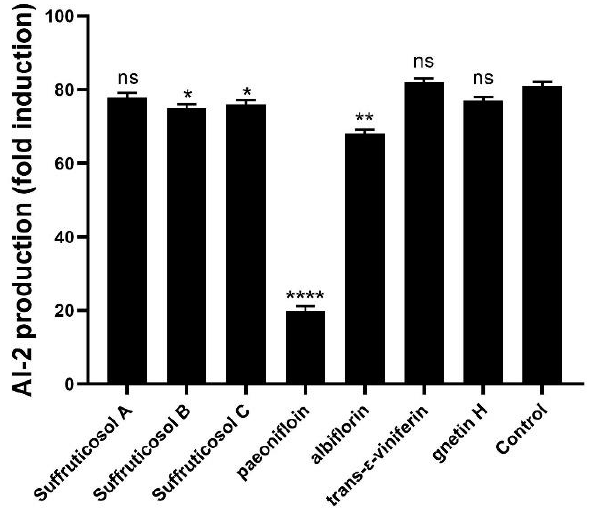
Figure 4. Suffruticosol A, suffruticosol B, suffruticosol C, paeonifloin, albiflorin, trans- ε -viniferin, gnetin H and control inhibits the secretion of AI-2 signaling molecule by S. suis . Data are shown as the mean ± SD. Statistical significance was assessed by unpaired Student’s two-sided t -test compared to the control group. * p < 0.05, ** p < 0.01, **** p < 0.0001. All experiments were performed in triplicate.